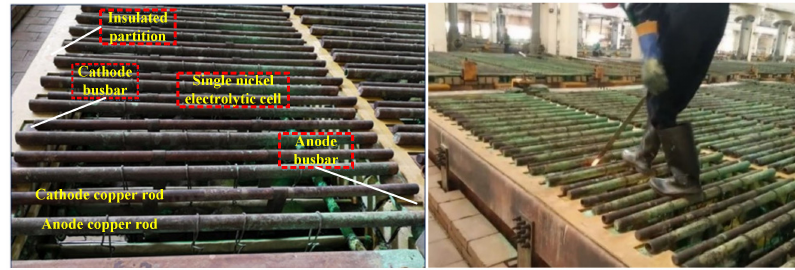
Figure 1. The nickel electrolytic cells and the conventional manual detection.